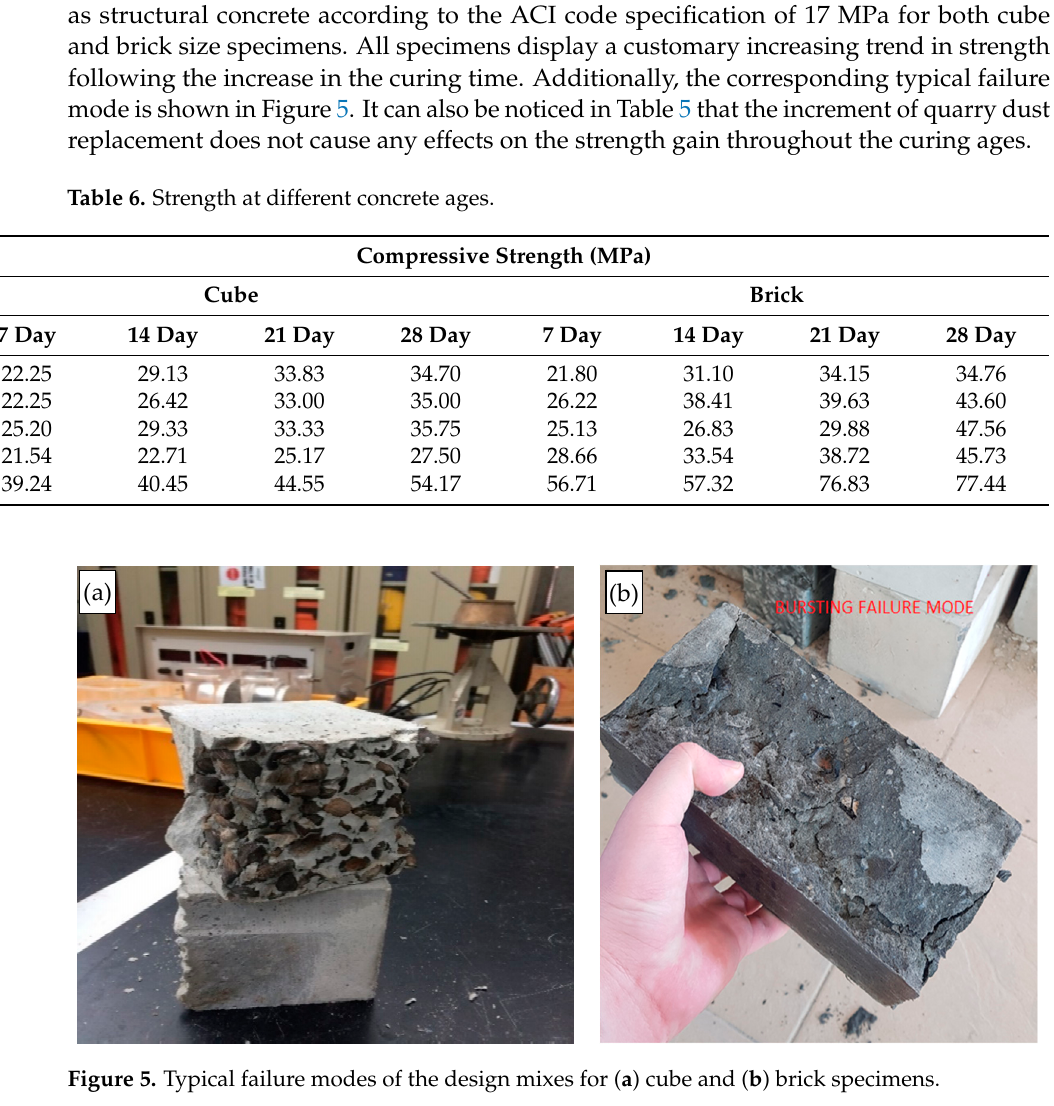
Table 5. Slump results and density measurements for the design mix.